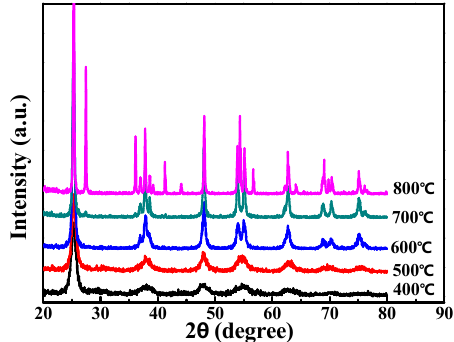
Figure 4. XRD spectra of nano-TiO 2 calcined at different temperatures. Table 1. Size of nano-TiO 2 and crystallinity calculated by XRD (X-ray di ff